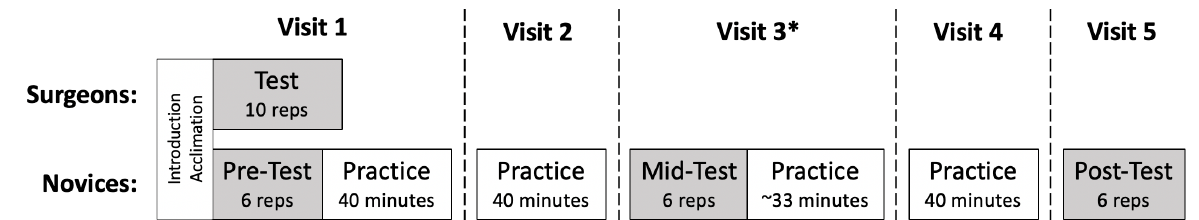
Figure 2. Study procedures illustrating common introduction and acclimation for both groups, as well as timed test periods with eye tracking recorded shown in gray and untimed practice periods without eye tracking shown in